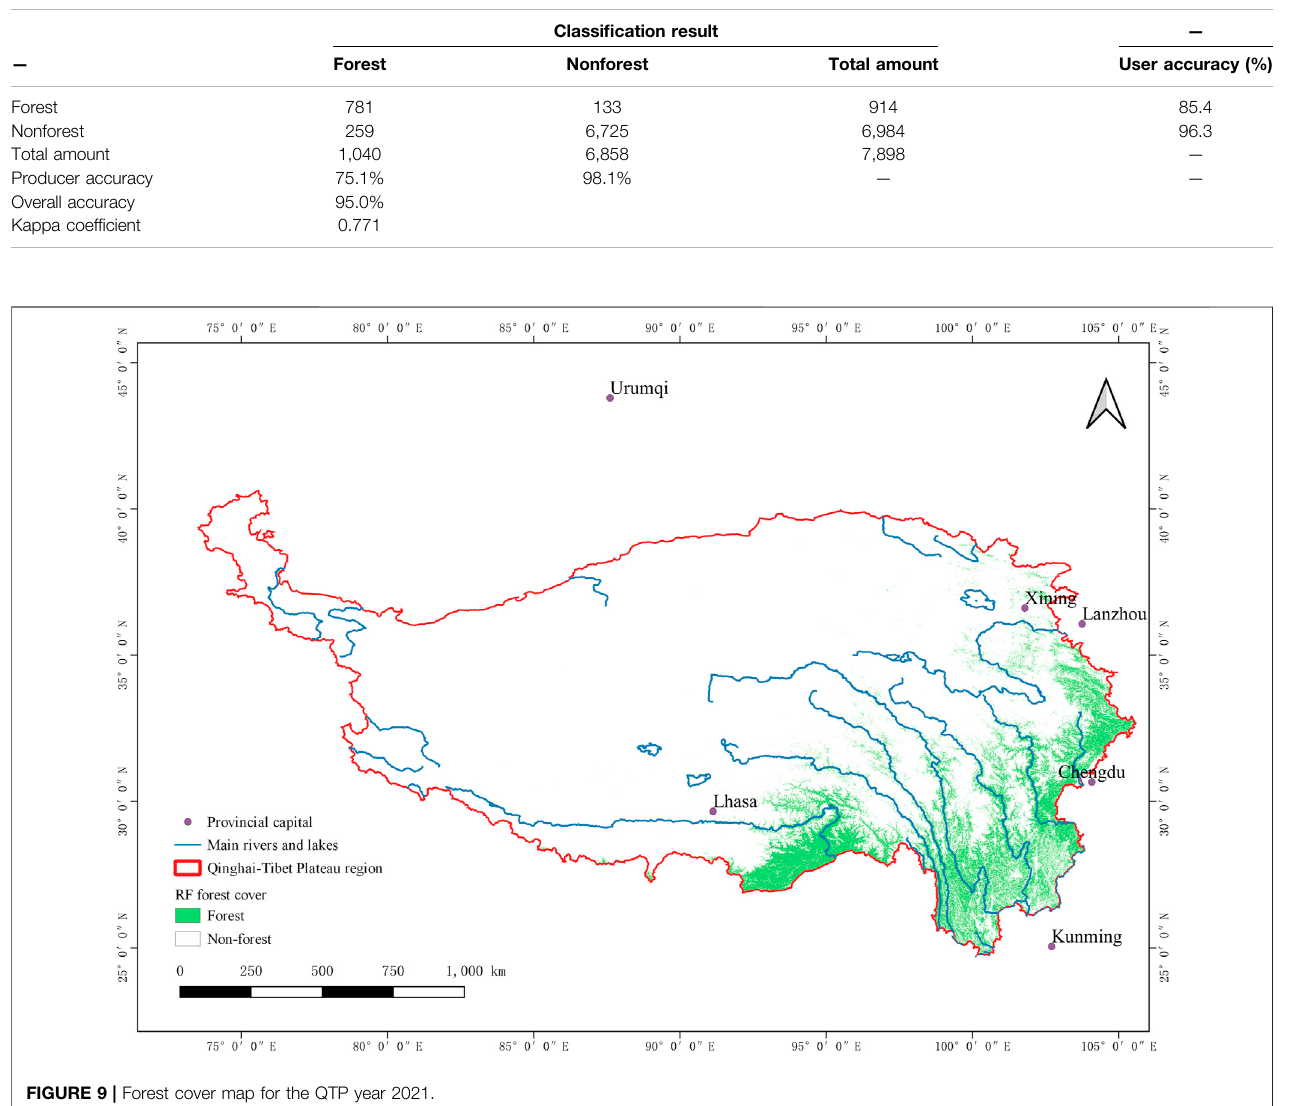
TABLE 4 | Confusion matrix of the ESA WorldCover 2020 Forest layer.